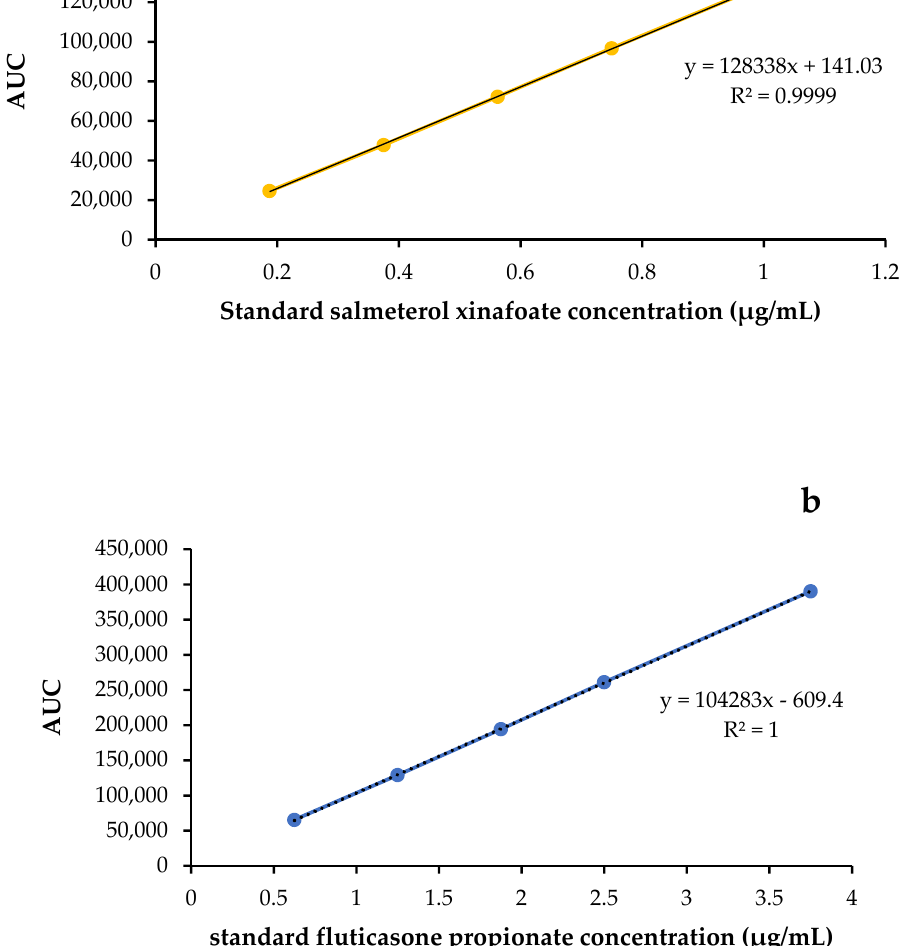
Figure 6. HPLC calibration curves of ( a ) salmeterol xinafoate and ( b ) fluticasone propionate.